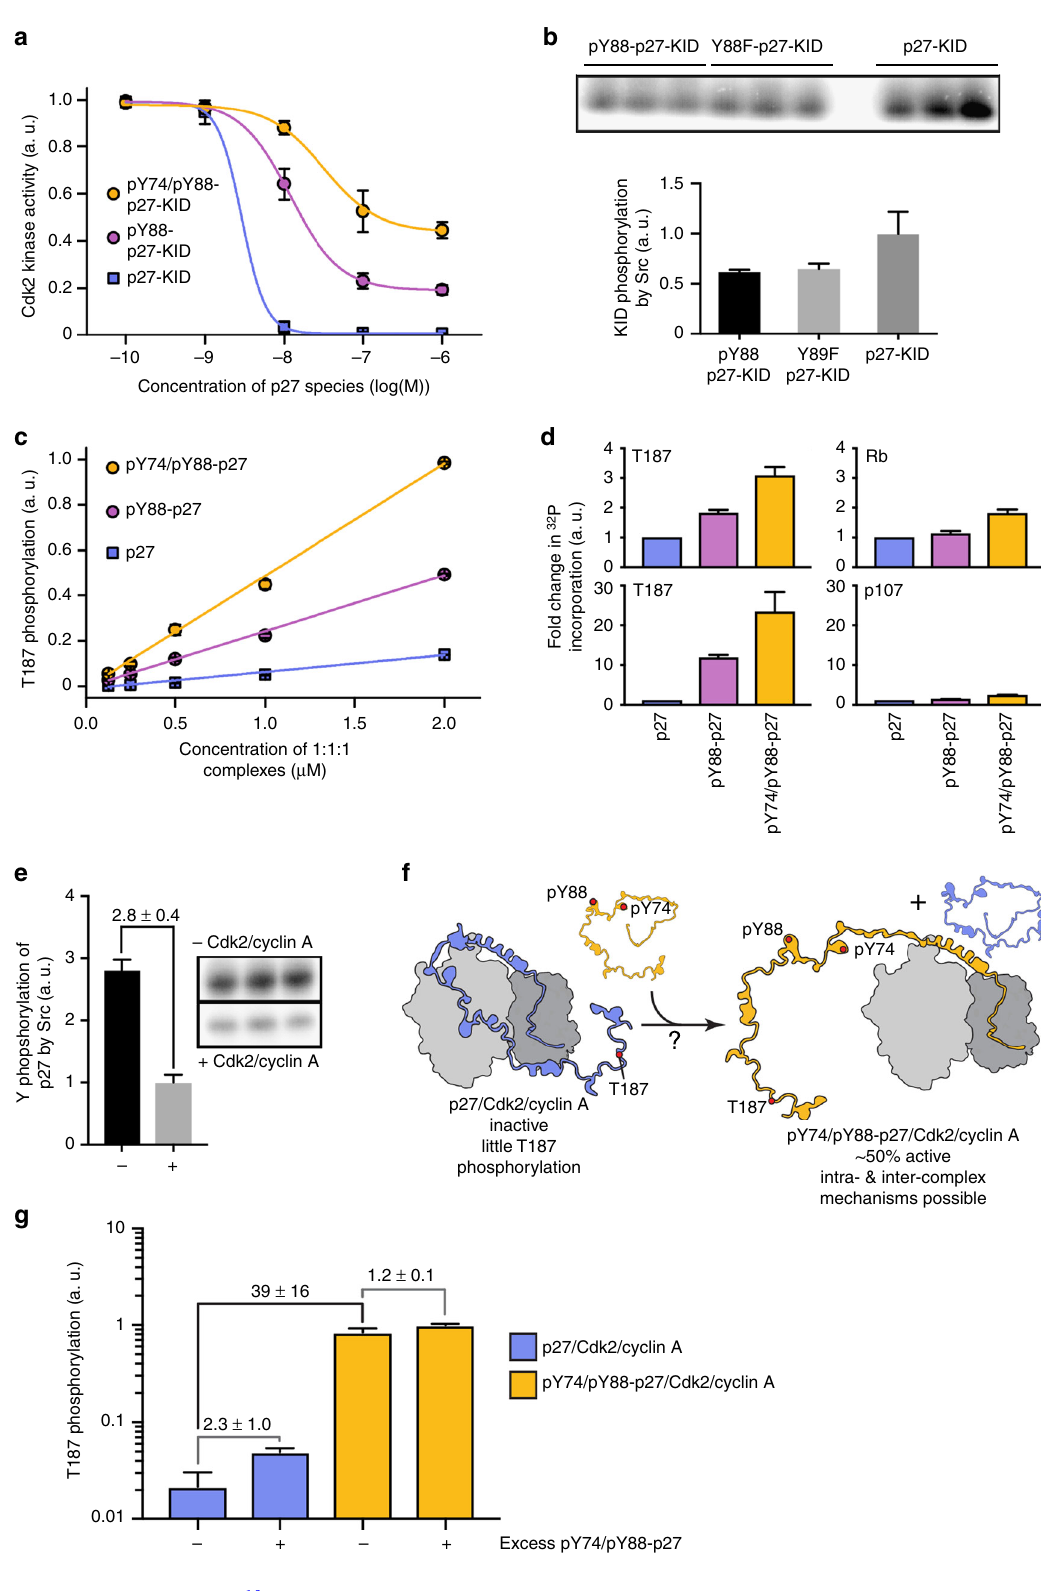
in 1:1:1 Cdk2/cyclin A/p27 assemblies (Fig. 2c, Supplementary Figure 2A); this arises from bi-molecular reactions (termed the inter-molecular mechanism) between a small amount of free (and active) Cdk2/cyclin A and T187 within either free or Cdk2/ cyclin A-bound p27. T187 phosphorylation is enhanced by prior phosphate incorporation into pY88-p27 (Fig. 2c), and